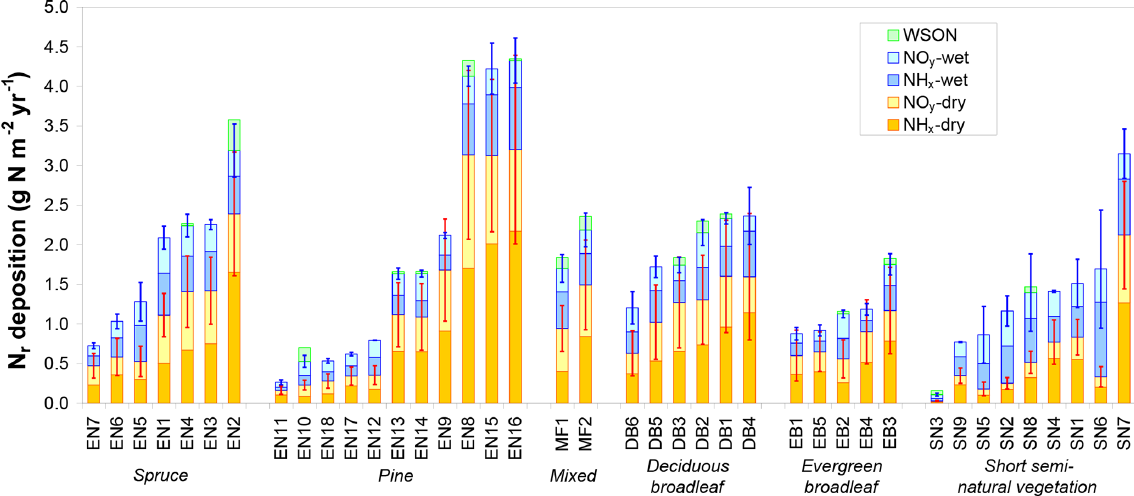
Figure 2. Total reactive nitrogen deposition ( N dep ) and breakdown into inorganic wet and dry, oxidized (NO y ) and reduced (NH x ) deposition estimates at the 31 forest sites (evergreen needleleaf EN1-7 (spruce), EN8-18 (pine), mixed – MF, deciduous broadleaf – DB, evergreen broadleaf – EB) and at nine short semi-natural (SN) vegetation sites of the NitroEurope monitoring network. Data are arithmetic means over the years 2007–2010 of (i) inferential dry deposition estimates by four different models based on in situ atmospheric N r measurements and of (ii) different wet deposition estimates from precipitation monitoring datasets and from European-scale atmospheric chemistry and transport modelling (EMEP). Error bars indicate standard deviations of the four dry deposition models (red bars) and standard deviations of the different data sources for inorganic N r wet deposition (blue bars). Wet deposition of water-soluble organic nitrogen (WSON) was measured at a few selected sites and is shown here for comparison with total inorganic N r